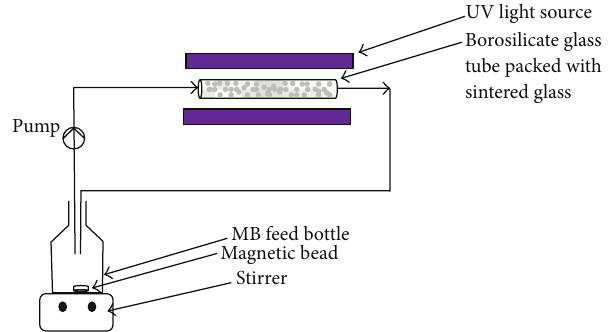
Figure 2: Experimental setup for the photocatalytic degradation of MB.